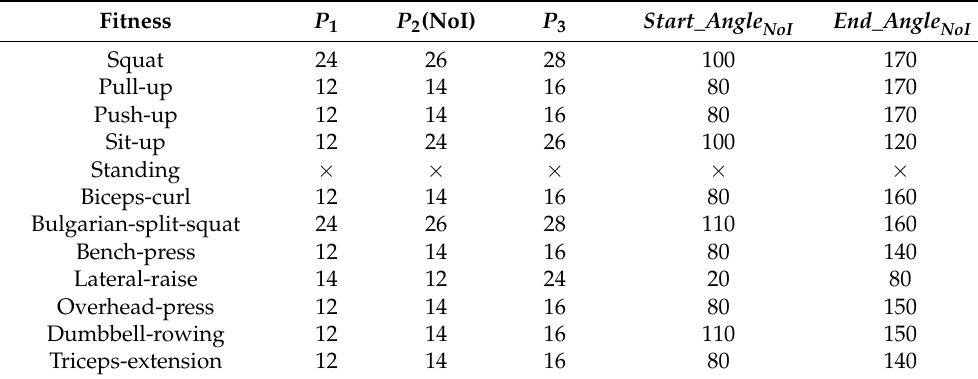
Table 7. The position of 𝑃 (cid:2869) , 𝑃 (cid:2870) , and 𝑃 (cid:2871) corresponding to the body node in Figure 3.